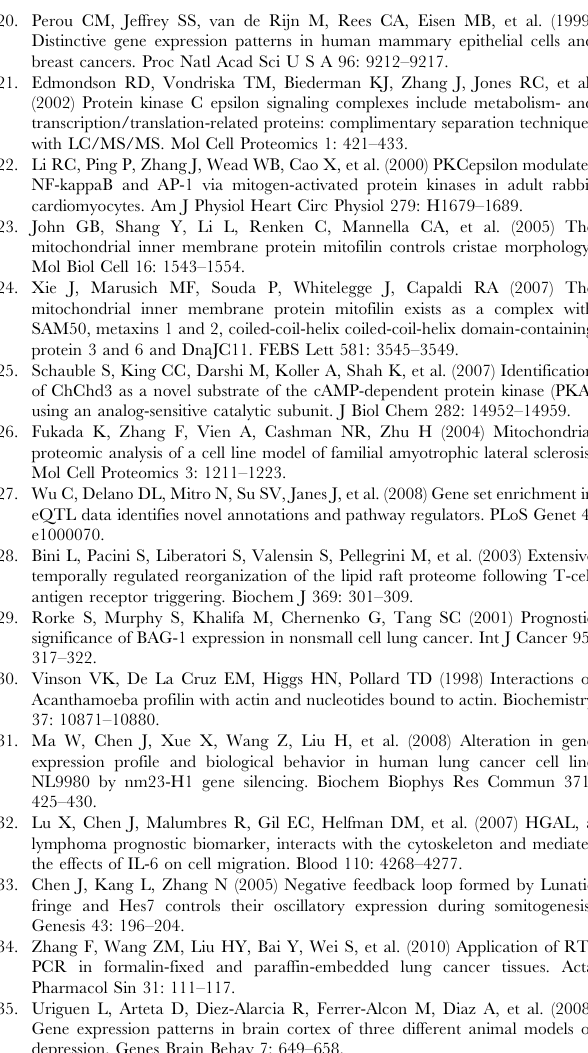
antibody. (TIF) Table S1 The upregulated genes in A549-FLJ-siRNA cells. (XLS) Table S2 The downregulated genes in A549-FLJ-siRNA cells. (XLS) Table S3 The differentially expressed genes involved in cell signaling pathways in FLJ20420-silenced A549 cells .